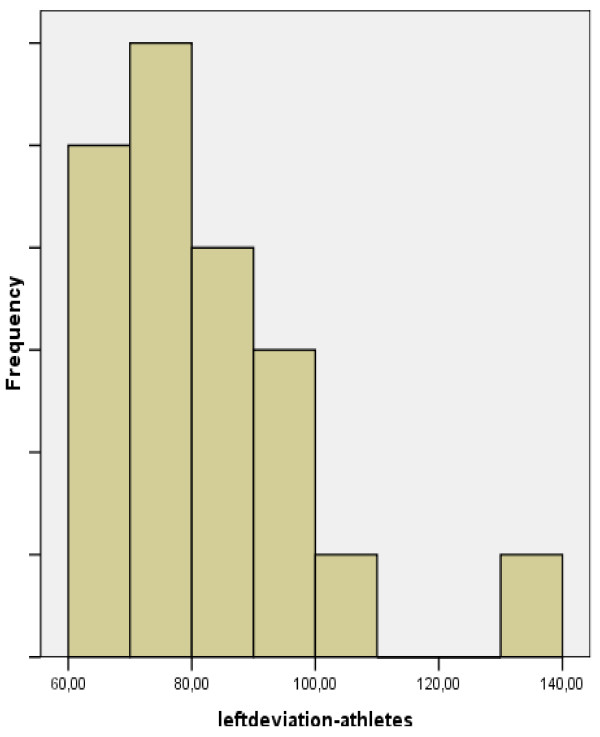
Graph depicting total deviation in the left hand of athletes.